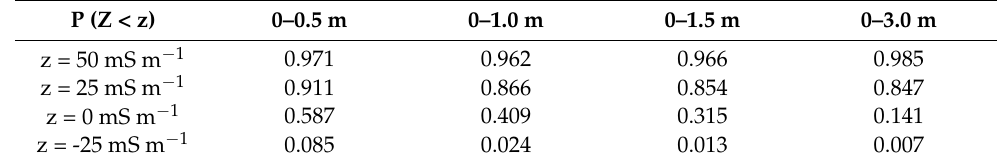
Table 2. Probabilities, P (Z ≤ z), of the increments in ECa between 2013 and 2017 for the four